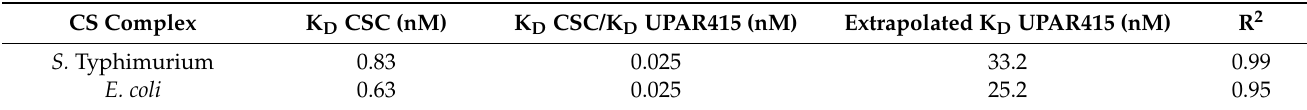
Table 2. CS complex dissociation constants obtained from the fitting with Equation (4) (Figure 7) of SPR and fluorescence data, corresponding to the K D,app values for CS complex formation in the presence of increasing concentrations of UPAR415. CS